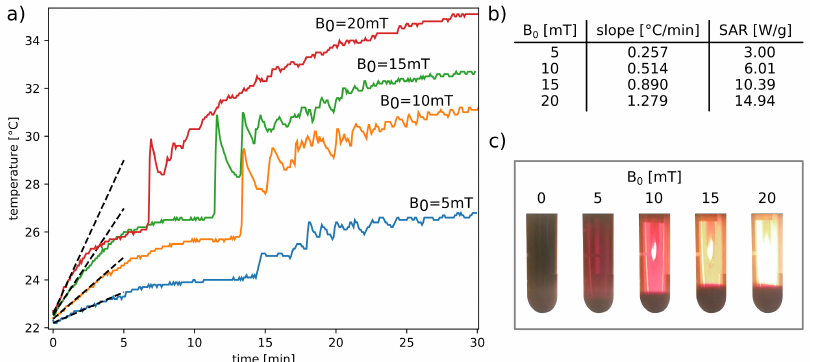
Figure 7. The left panel ( a ) presents the surface temperature changes during the RFMH process for various NP suspensions. Table ( b ) collects the specific absorption rates (SAR) of the nanoparticles for several amplitudes of the RF magnetic field [73], whereas the photo collage ( c ) shows how the supernatant changes after the 1800 s exposure to a RF magnetic field, depending on its magnitude. In the ( b ) case, the linear fit was determined from the first 60 s of the RFMH process. In the ( c ) case, each of the five tubes was additionally illuminated from the back with the same light